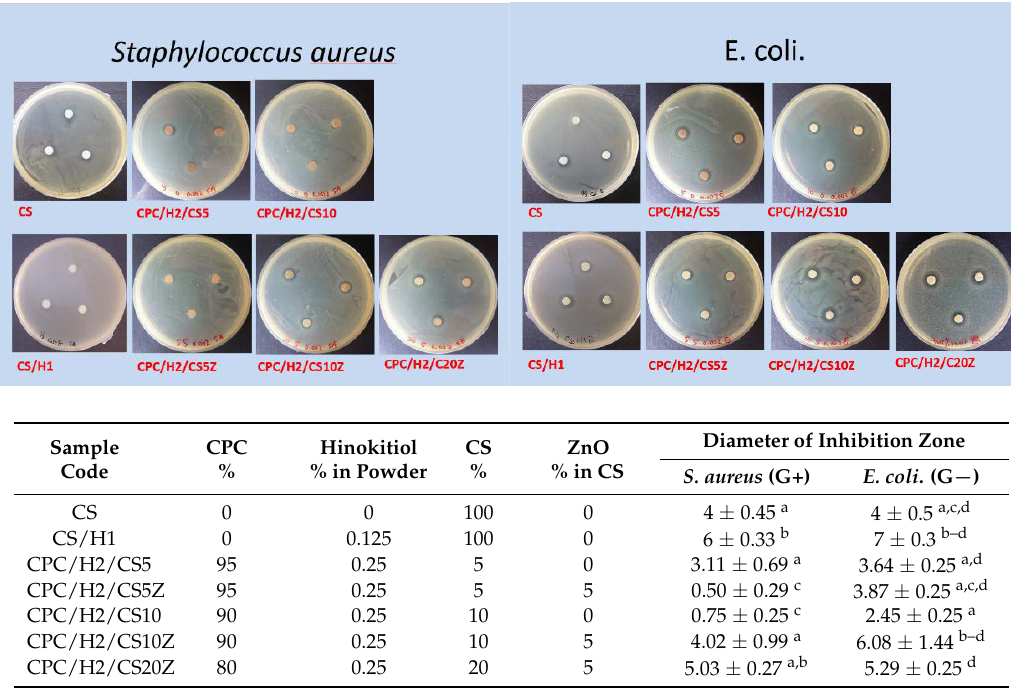
Figure 5. Summarized of the diameter of inhibition zones (in mm) of CS, CS/H1 and CPC/H2 with different CS compositions on S. aureus and E. coli . The data in the same statistical level was marked with the same letter (a, b, c, and d) after the data.